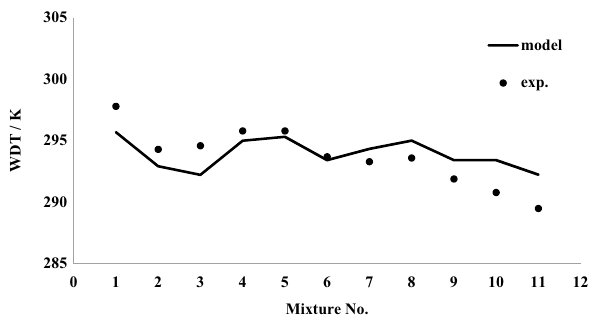
Fig. 5 Comparison of experimental (Metivaud et al. 1999) and pre- dicted WDT vs. mixture number for system #2